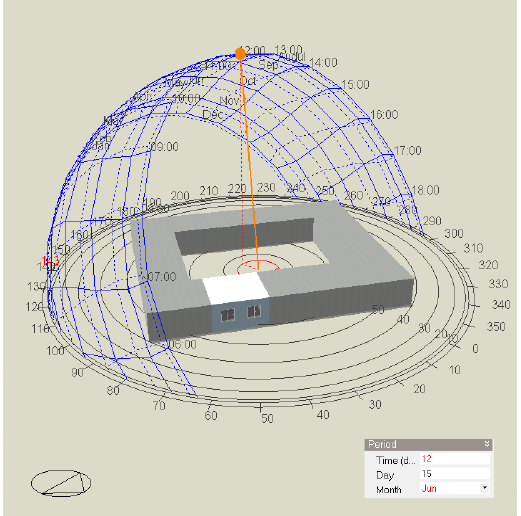
Figure 6. School building orientation with the sun path timing—classroom shown in white colour (from the DesignBuilder